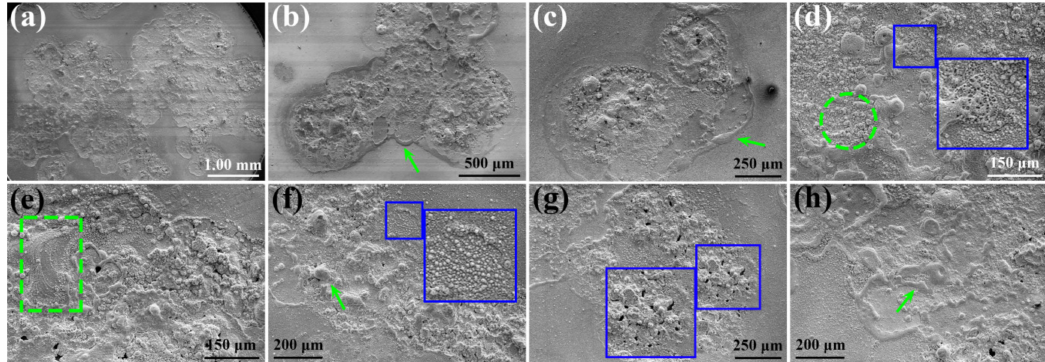
Figure 3. SEM images of ( a ) whole eroded Cu-Ti 3 AlC 2 surface; ( b , c ) ablation edge; ( d ) coral-like particles; ( e ) molten liquid accumulation; ( f ) protrusions; ( g ) black holes; ( h ) ablation edge after being eroded 100 times by arc discharging.